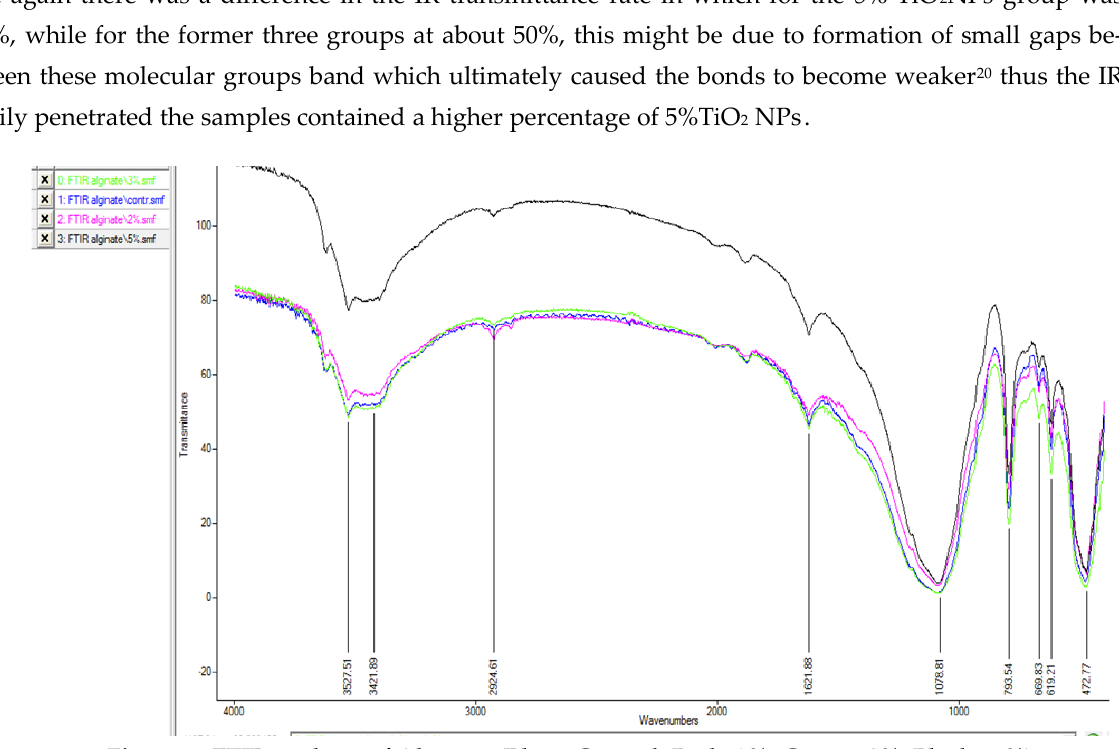
Figure 3 : FTIR analysis of Alginate (Blue =Control, Pink=2%, Green =3%, Black=